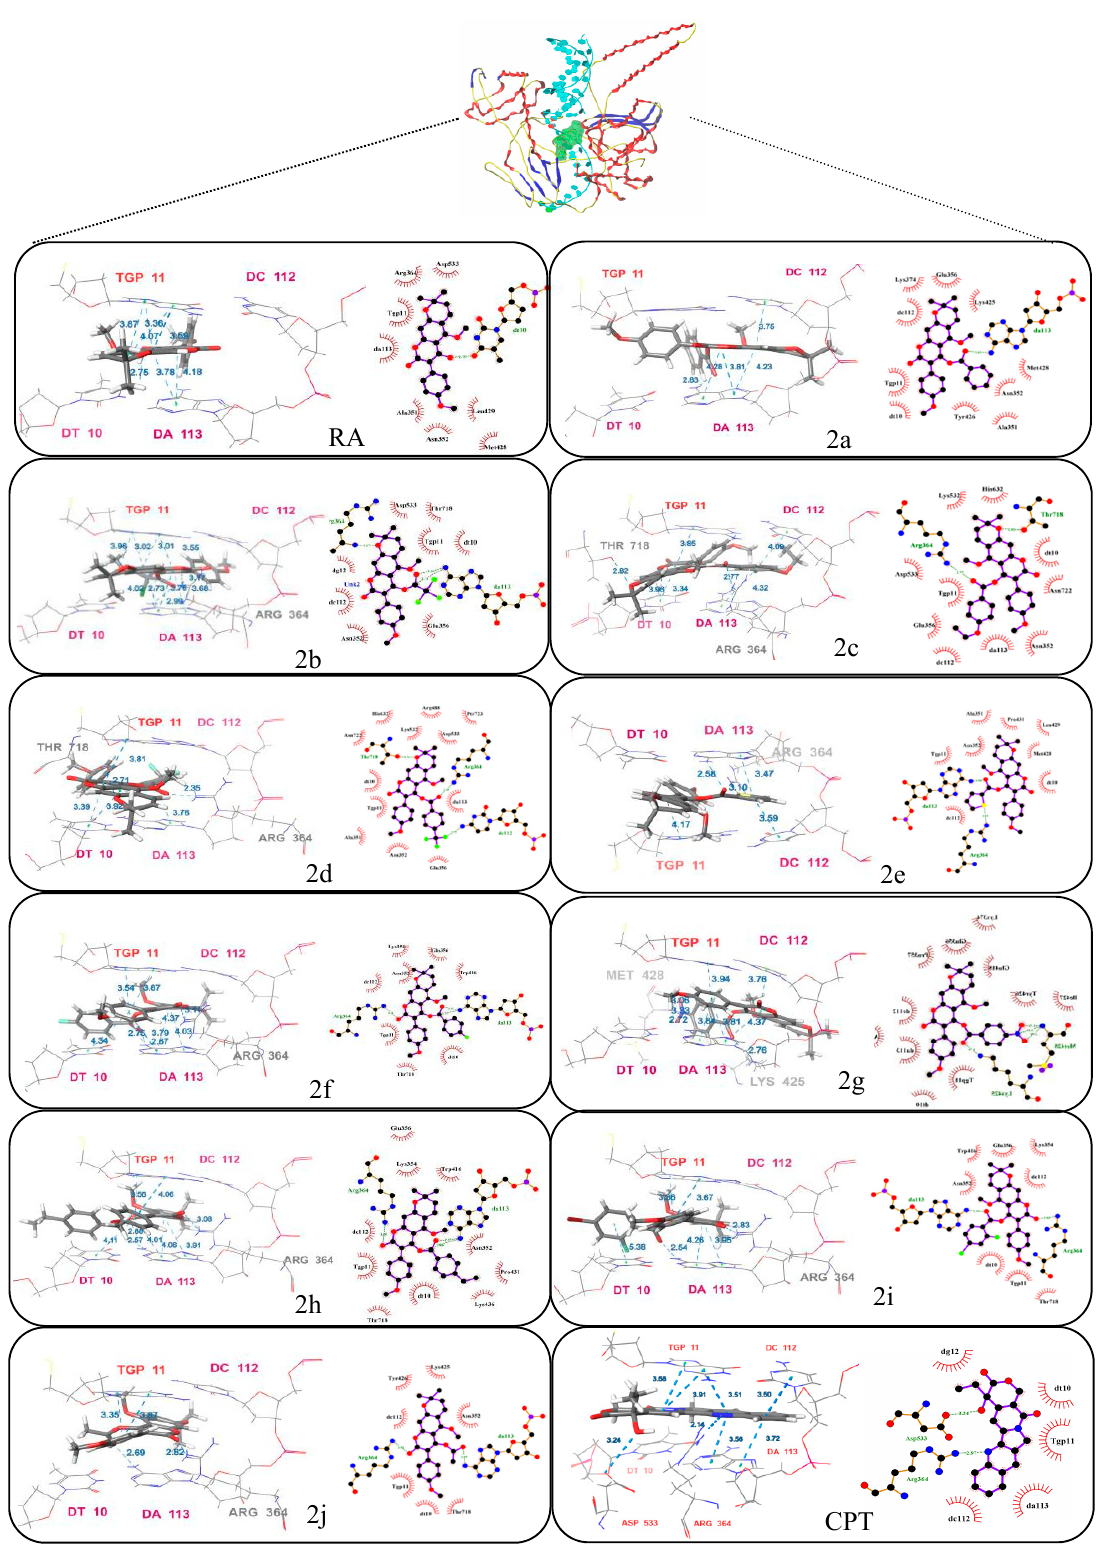
Figure 7. The best pose of the binding mode of compounds with DNA-Topo I complex (PDB:1T8I).